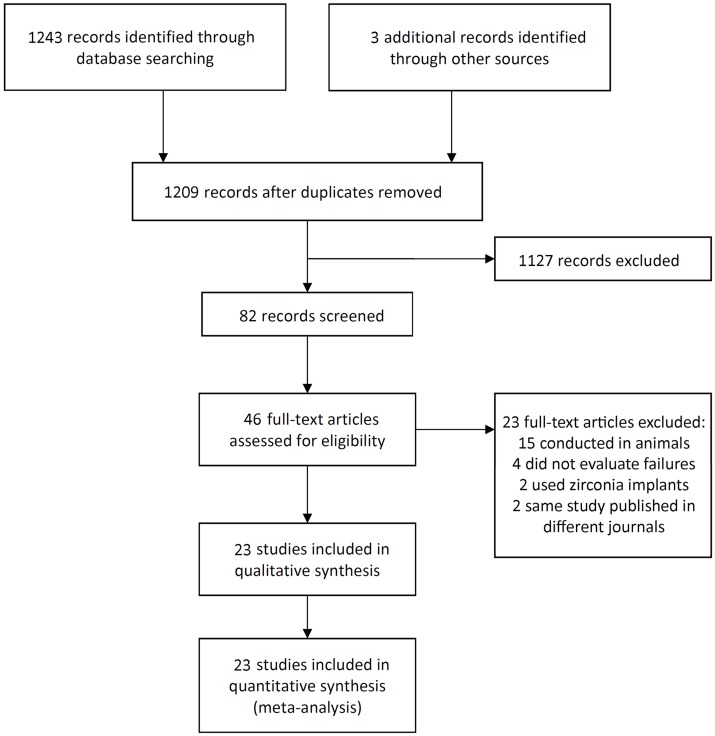
Study screening process – flow diagram.